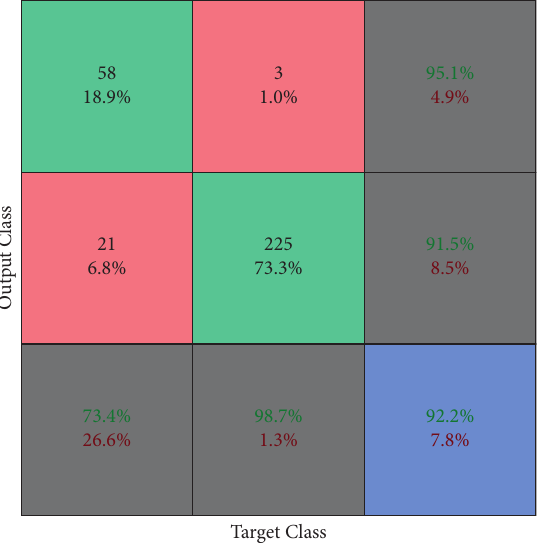
Figure 13: Confusion matrix plot of proposed plant leaf detection using Bayesian optimized support vector machine